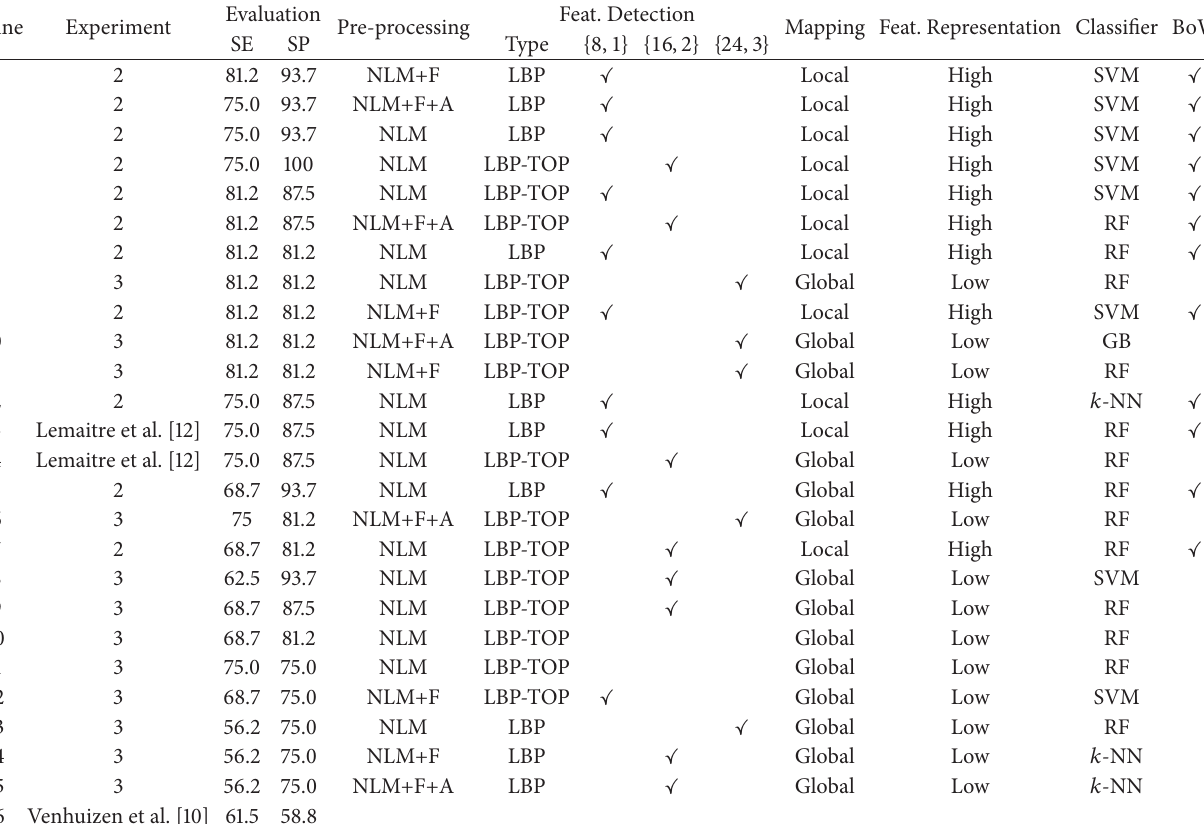
Table 5: Summary of all the results in descending